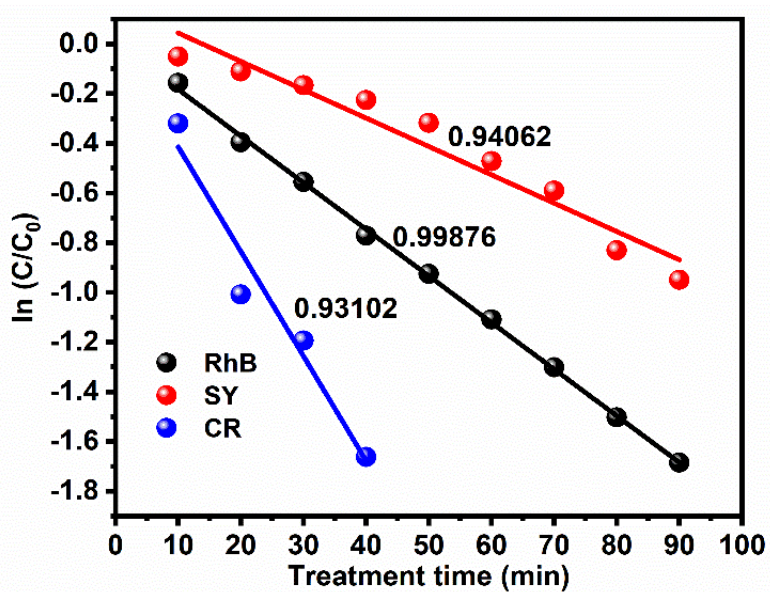
Figure 7. Pseudo-first-order kinetic rate constant for photocatalytic degradation of three different dyes.